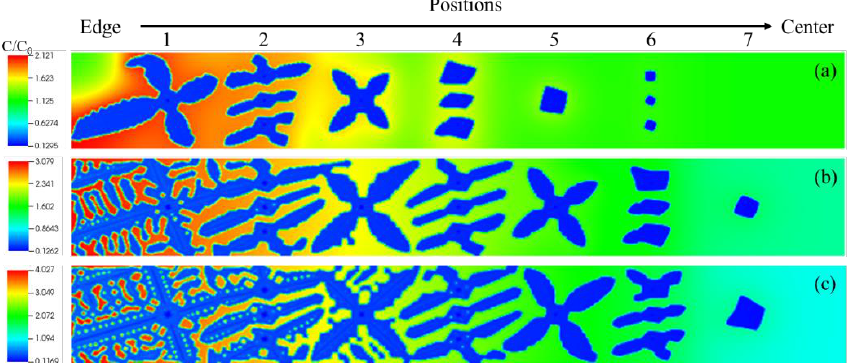
Figure 8. Distribution of solute concentration at time step 100,000 Δt under different temperature gradients, ( a ) 0.230 °C/mm, ( b ) 0.442 °C/mm and ( c ) 0.657 °C/mm.